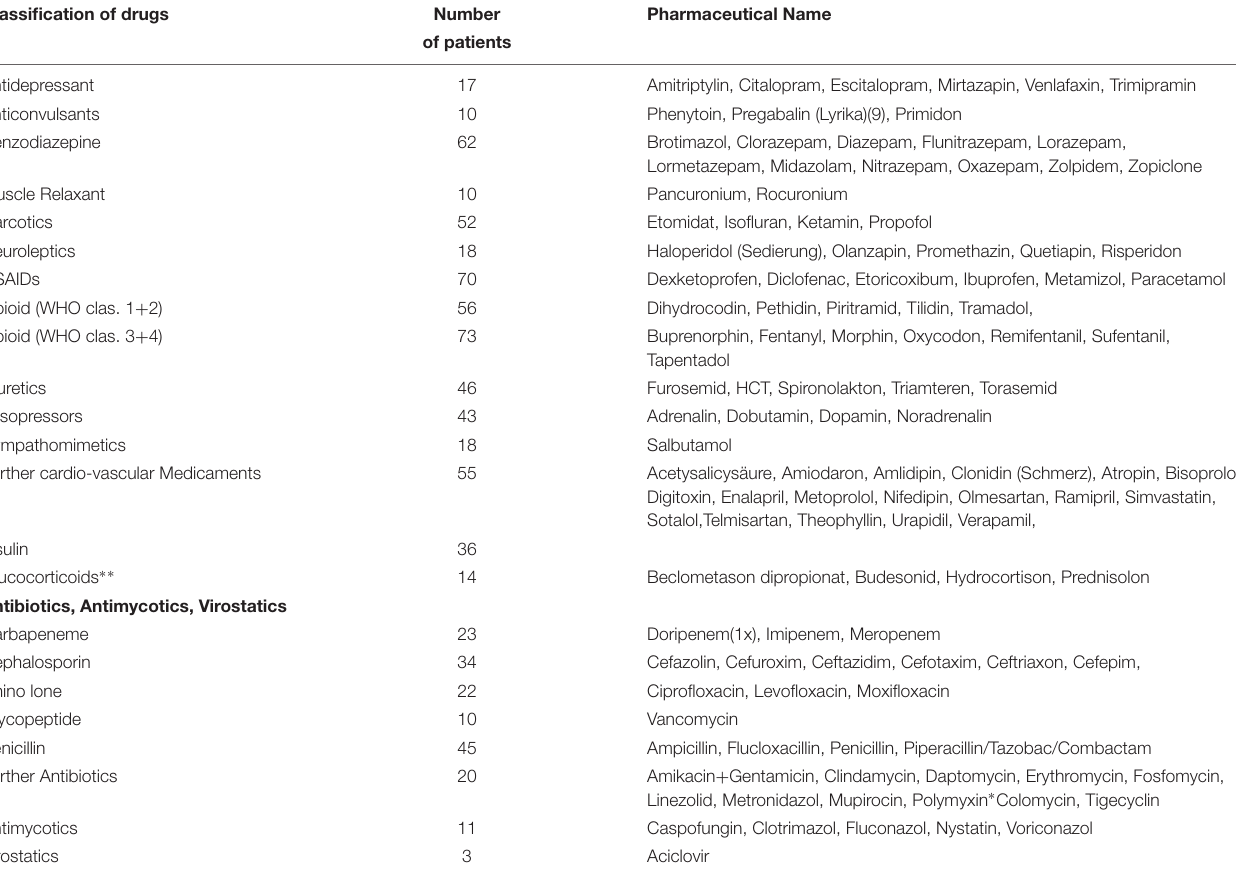
TABLE 9 | Concomitant medication of ITT